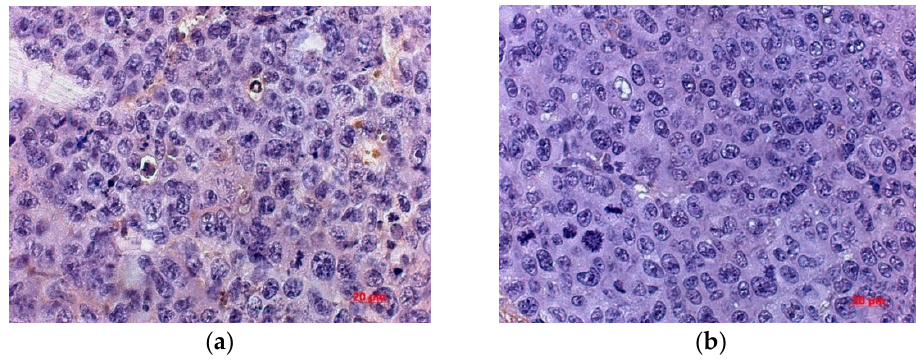
Figure 8. Immunohistochemical assay with the CD34 marker in endothelial cells in mice tumor tissue without virotherapy ( a ) and after a course of virotherapy ( b ) on the 20th day after the course of injections (28th day of tumor growth), 63× magnification.